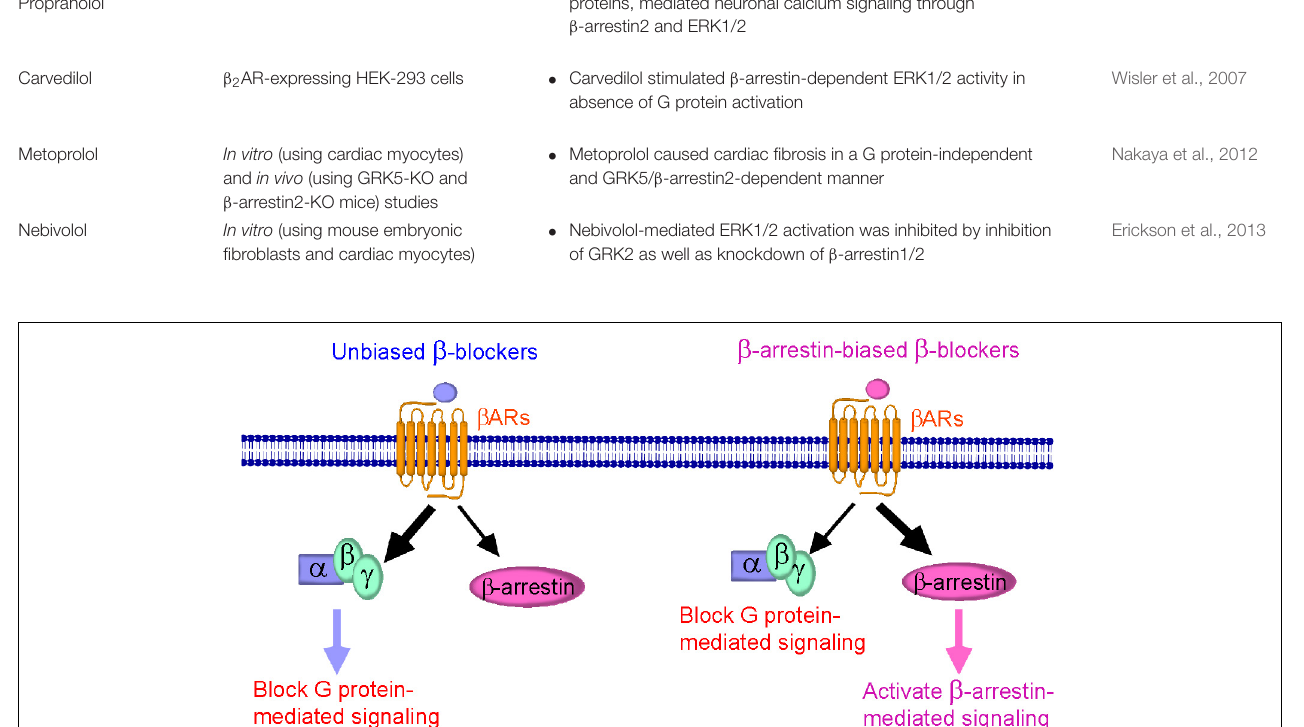
FIGURE 1 | Schematic diagram representing β -blockers mediated β -arrestin-biased signaling. (Left) Binding of unbiased (classical) β -blockers (blue) to β ARs resulted in an unbiased response inhibition of G protein-mediated signaling. (Right) Binding of β -arrestin-biased β -blockers (pink) to β ARs stabilizes the receptor into a distinct conformation that preferably activates β -arrestin-mediated signaling, resulting in cardioprotection, and is also able to block G protein-mediated